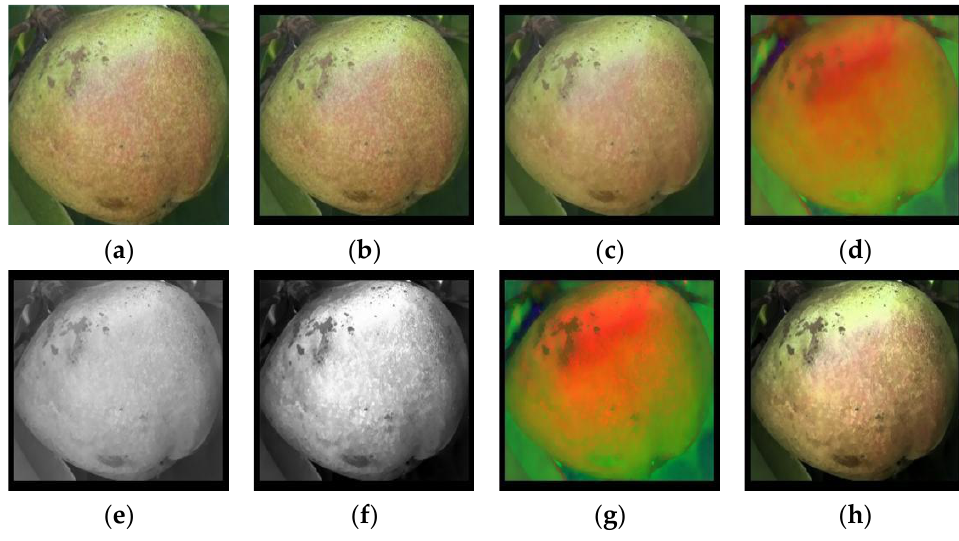
Figure 5. Image preprocessing. ( a ) ROI, ( b ) Pixel expansion, ( c ) Bilateral filtering, ( d ) RGB to HSV, ( e ) V component diagram, ( f ) Histogram equalization of V component graph, ( g ) Merge, ( h ) Consolidated enhanced HSV to RGB.